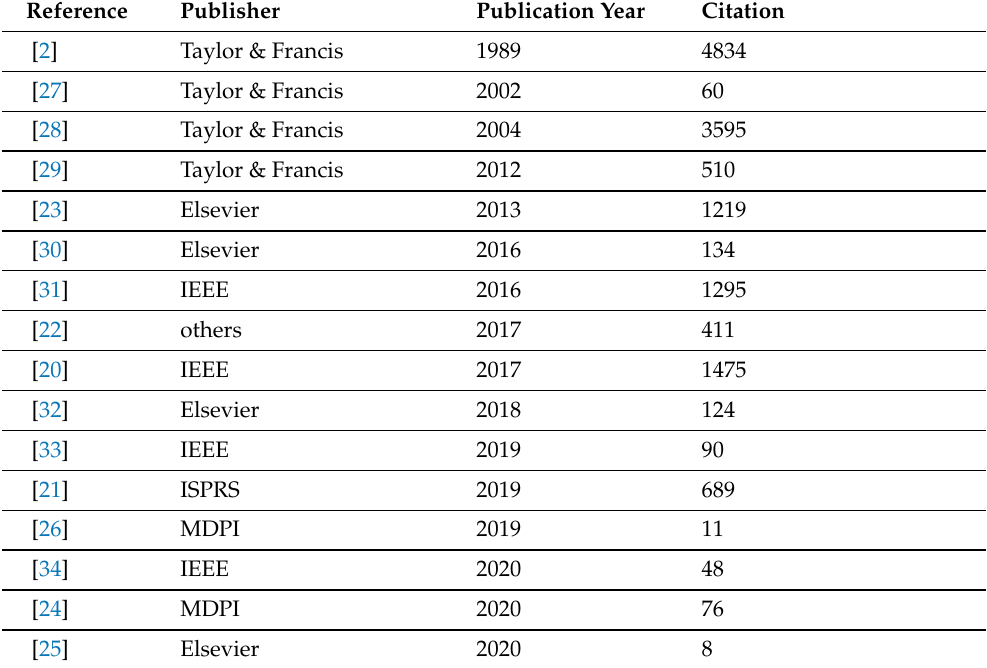
Table 1. Summary of survey papers on change